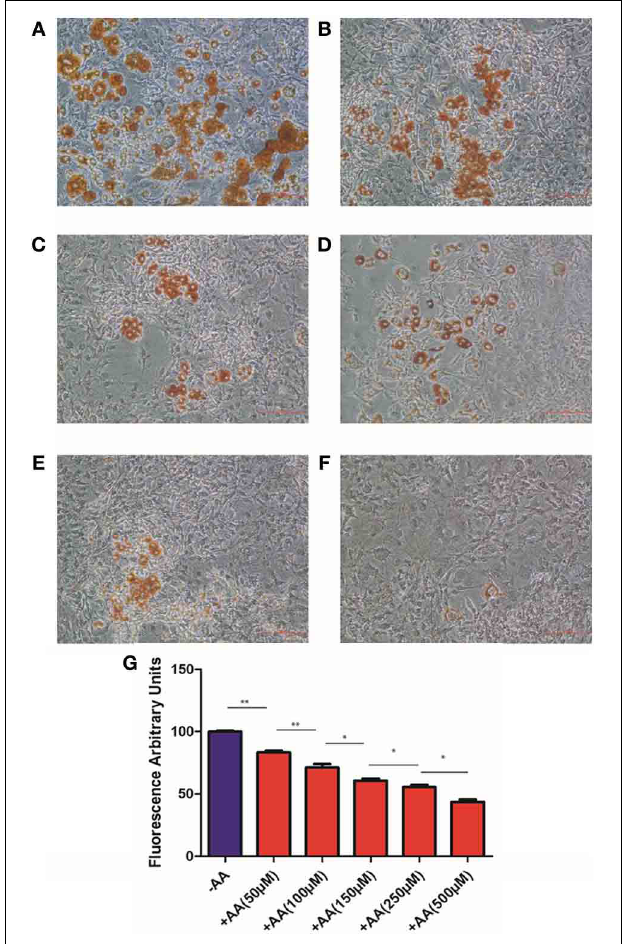
FIGURE 2 | 3T3L1 differentiation. Cells were cultured, without IBMX, during 9 days without AA (A) or with 50 μ M (B) , 100 μ M (C) , 150 μ M (D) , 250 μ M (E) , and 500 μ M (F) . After 9 days cells were stained with Oil Red O. (G) In an independent experiment 3T3-L1 cells were cultured with or without AA.After9days, AdipoRed wasadded andfluorescence recorded (fordetails see Materials and Methods). Results are expressed in fluorescence arbitrary units. ∗ p < 0 . 05, ∗∗ p < 0 .